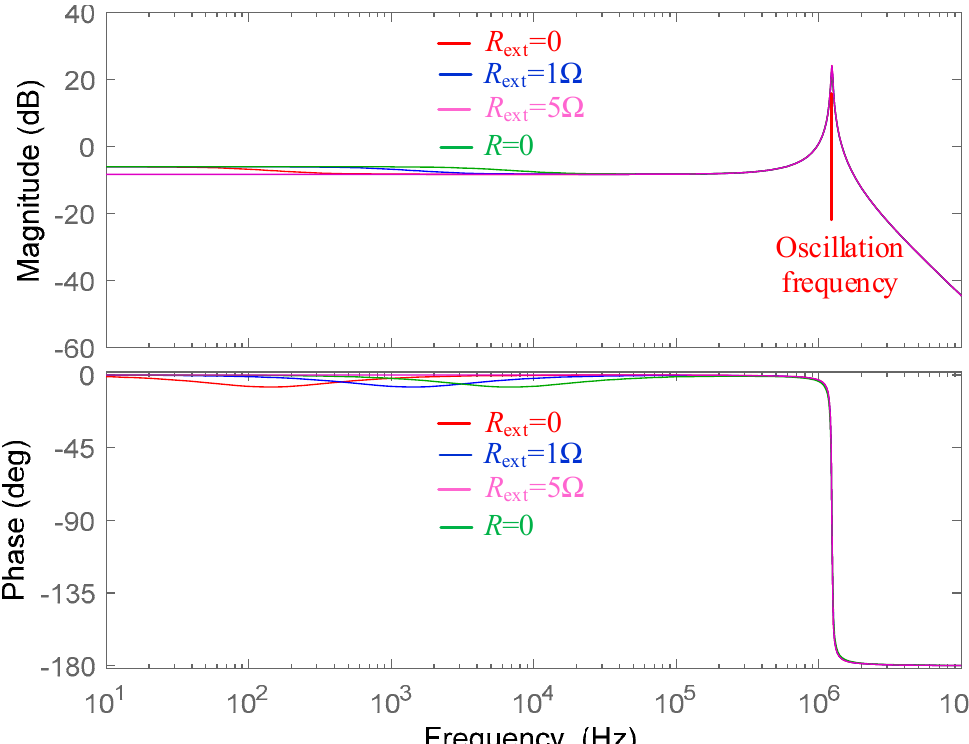
Figure 5. Bode plot of the voltage transfer function with different AC resistances.